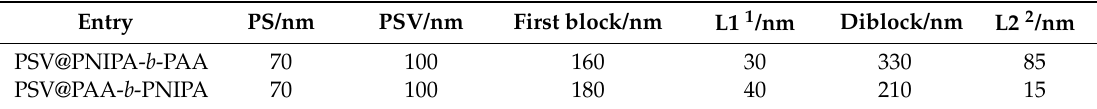
Table 1. Size of diblock polymer brush during synthesis procedure.